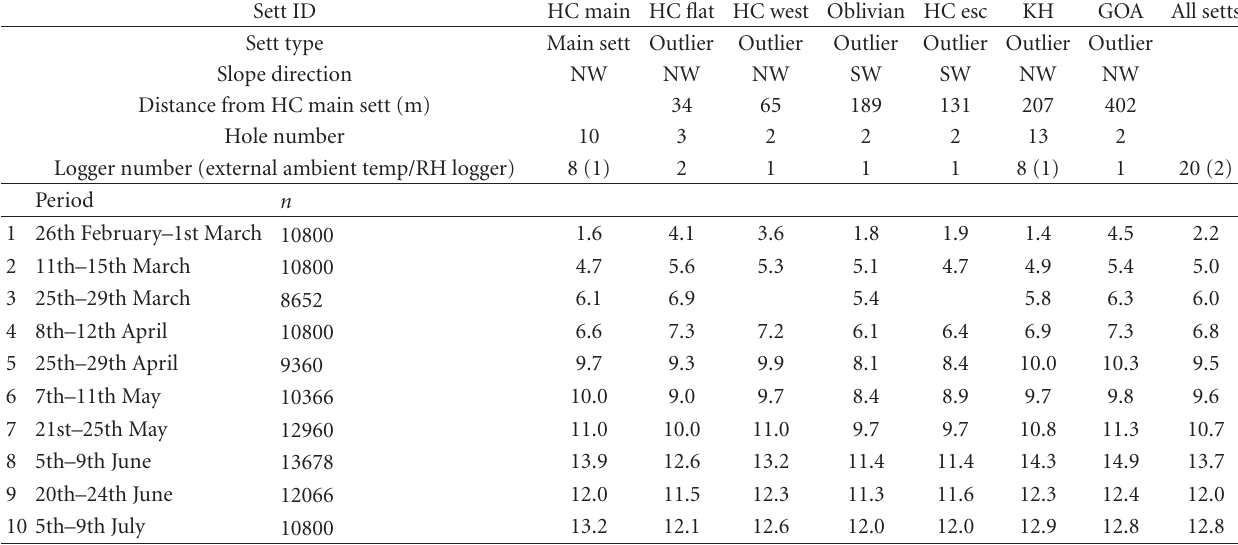
Table 2: Core internal sett temperature (CIST) in Hill Copse territory in Wytham, 2004. Sett